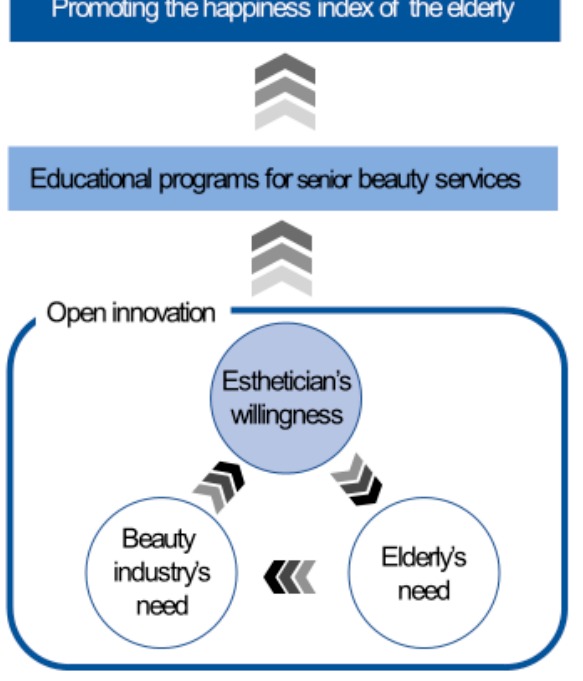
Figure 2. Esthetics program development model to improve elderly happiness index.